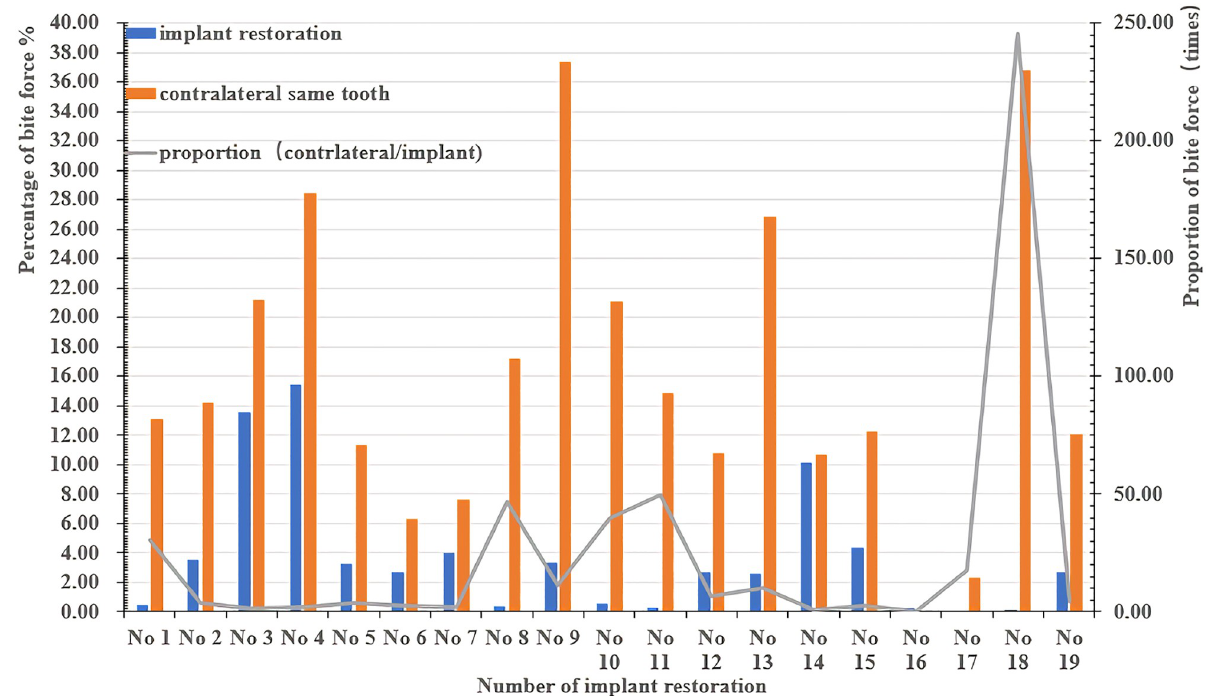
Fig 2. Percentage and proportion of the bite force between contralateral same teeth and implant restorations (immediately following crown insertion). https://doi.org/10.1371/journal.pone.0252191.g002 anterior segments (Table 4). Although the occlusal force of the posterior quadrants on the restored side increased, the gap between bilateral occlusal forces was reduced for subjects with unilateral edentulousness but increased for those with bilateral edentulousness (Figs 4 and 5).